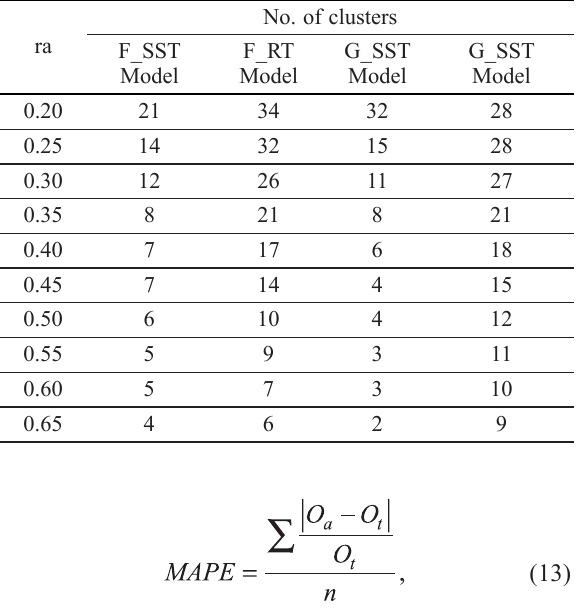
Table 1. Number of clusters for different assigned radius